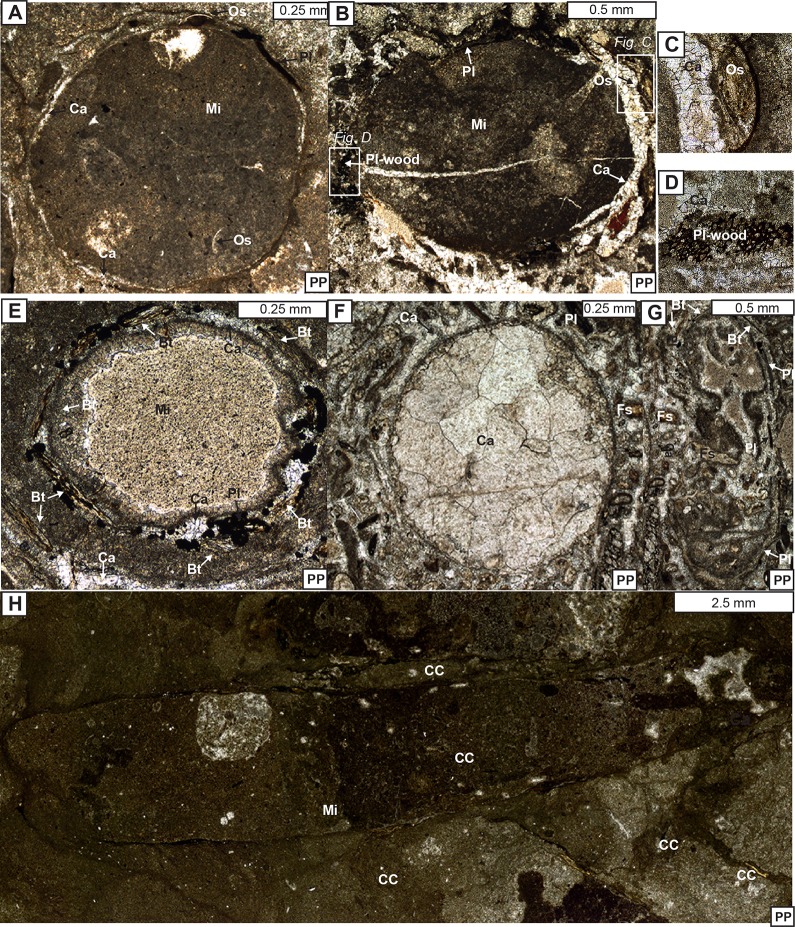
Photomicrographs of the caddisfly cases.(A) Caddisfly case in cross section. (B) Caddisfly case in cross section. (C) Close view of an ostracod case particle. (D) Close view of a plant-wood fragment. (E) Caddisfly case in cross section with biotite fragments. (F) Caddisfly case in cross section, filled with blocky calcite spar cement. (G) Oblique view of caddisfly case. (H) Caddisfly case in longitudinal section. Ca-calcite; Mi-micrrite; Pl-plant fragment; Os-ostracod; Bt-biotite; Fs-feldspar; CC-caddisfly case.